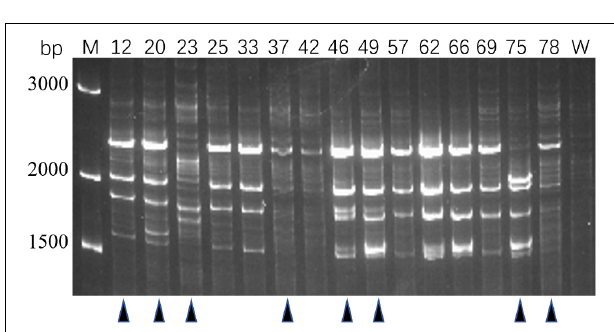
FIGURE 2 | Genotyping of typical PRM strains derived from V. alginolyticus E06333 by IRS-PCR. These PRM strains exhibit obviously different fingerprints from the primary V. alginolyticus E06333. The numbers on the top represent the strain numbers. The black triangles on the bottom present eight PRM strains that are further selected for subsequent analysis. Eight PRM strains were renamed (according to the order from left to right) as VAM01, VAM02, VAM03, VAM04, VAM05, VAM06, VAM07, and VAM08,